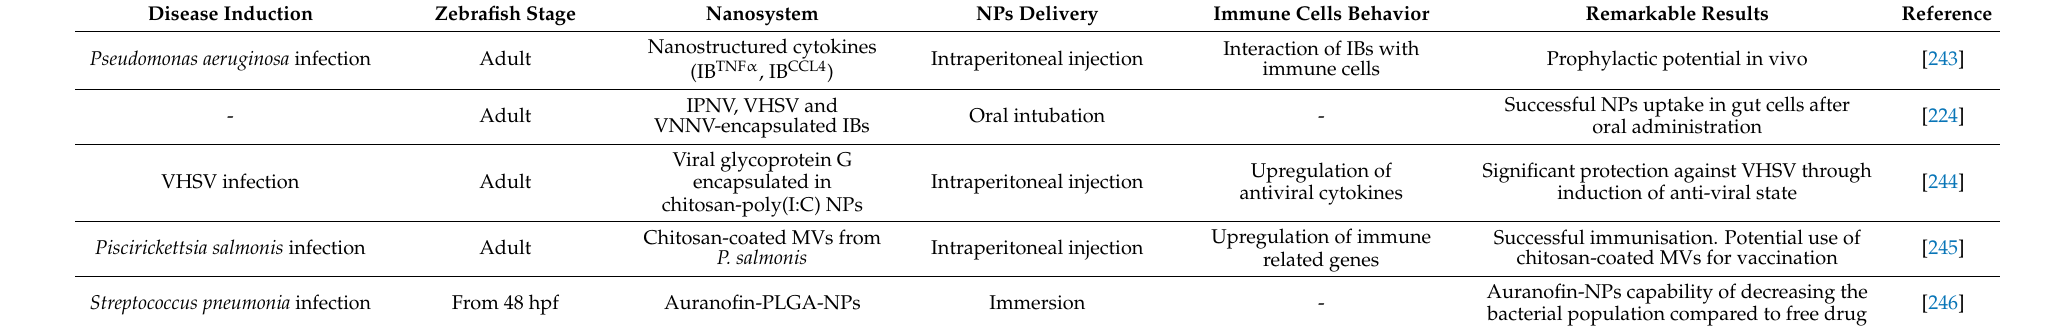
Table 3. Summary of nanoparticles tested in zebrafish models of infectious